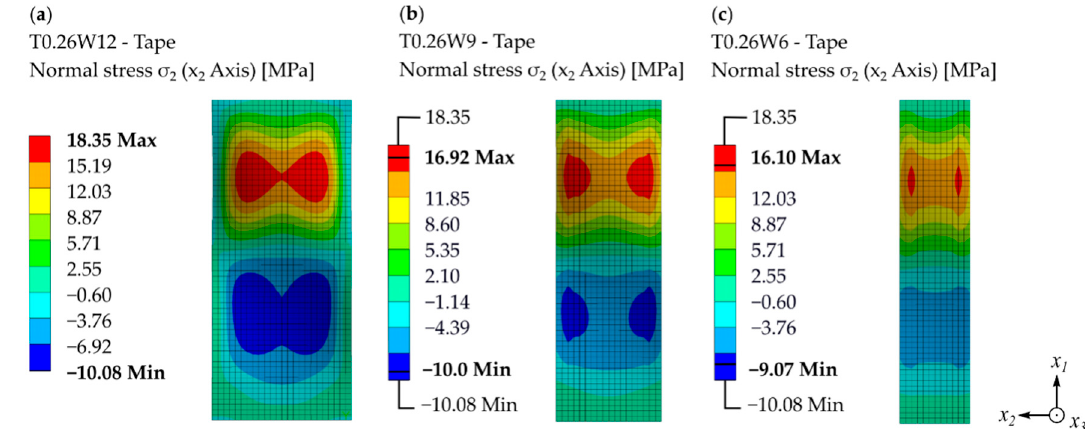
Figure 7. Comparison of the normal stress σ 2 distribution of the three tape widths ( a ) 12 mm, ( b ) 9 mm and ( c ) 6 mm with a tape thickness of 0.26 mm at the point of failure.